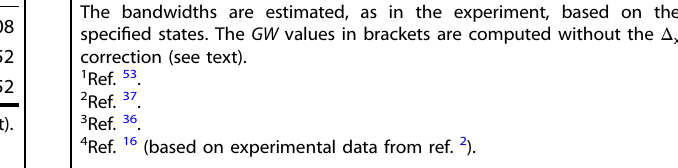
Table 1. Electron spin magnetic moments (in μ B ) of Fe, Co, and Ni computed with different techniques. LSDA